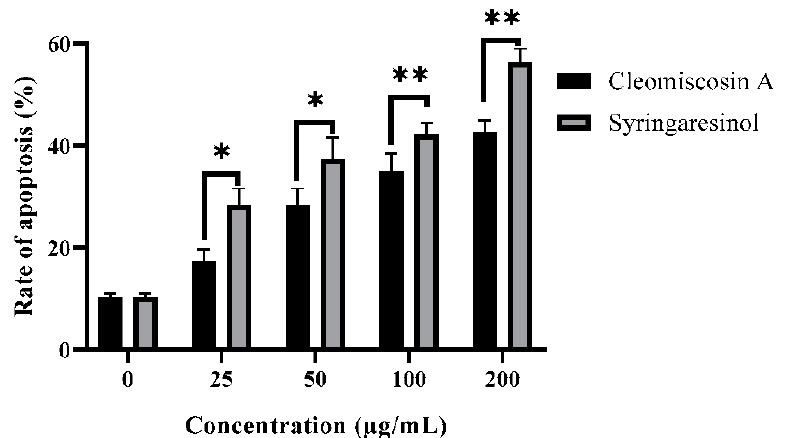
Figure 12. Apoptosis rates in A549 cells with or without treatment (control) by flow cytometry analysis. Cells were treated with syringaresinol and cleomiscosin A for 24 h. Data are represented as mean ± SD values of three independent experiments, where * p < 0.005 and ** p < 0.001.